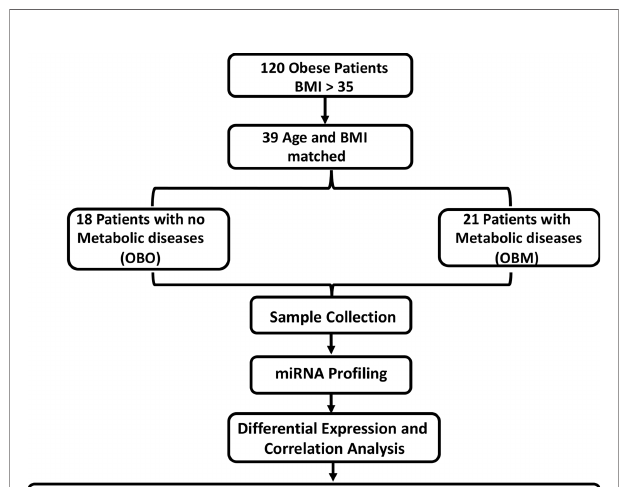
FIGURE 1 | The experimental study design. BMI, Body Mass Index; OBO, Obesity with no metabolic disease; OBM, Obesity with metabolic diseases. To determine the fold-changes of miRNA expression between the OBO vs OBM patients, we used the Relative Quanti fi cation (RQ) measure. We considered those miRNAs to be differentially expressed for which |log2(RQ)| > 2 and signi fi cance threshold p< 0.05. This resulted in the identi fi cation of 64 differentially expressed miRNAs. Out of the 64 miRNAs, there were 13 miRNAs whose expression correlated with at least one clinical trait of relevance for metabolic syndrome (including HBA1c, Creatinine, Cholesterol, LDL, and